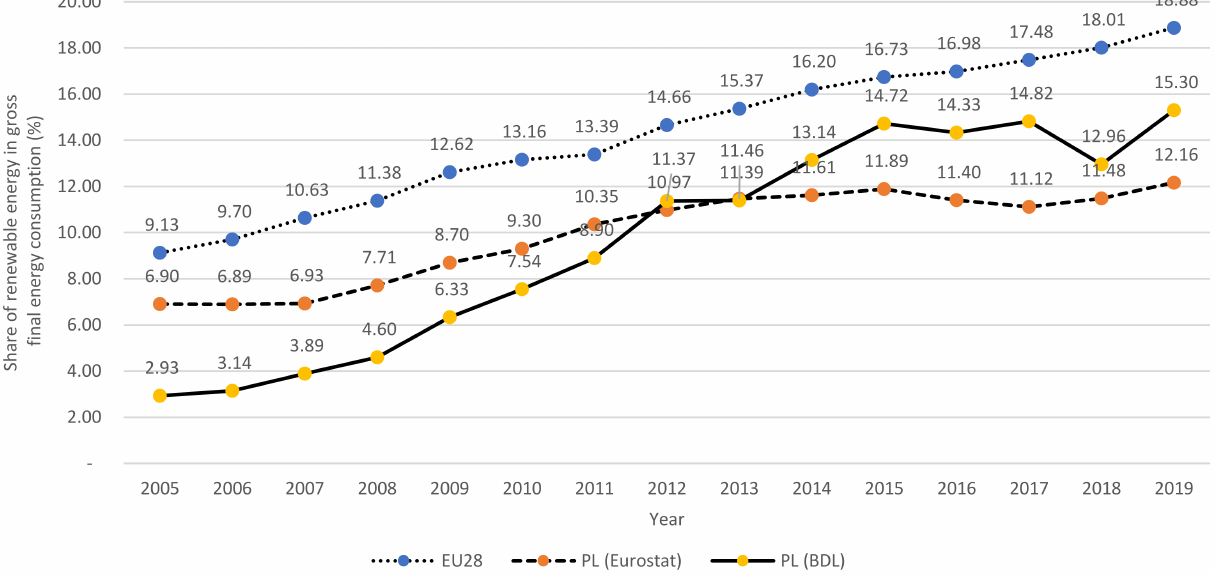
Figure A3. Share of renewable energy in gross final energy consumption (%) in Poland vs. EU28 in 2005–2019. Source: own elaboration based on [28],